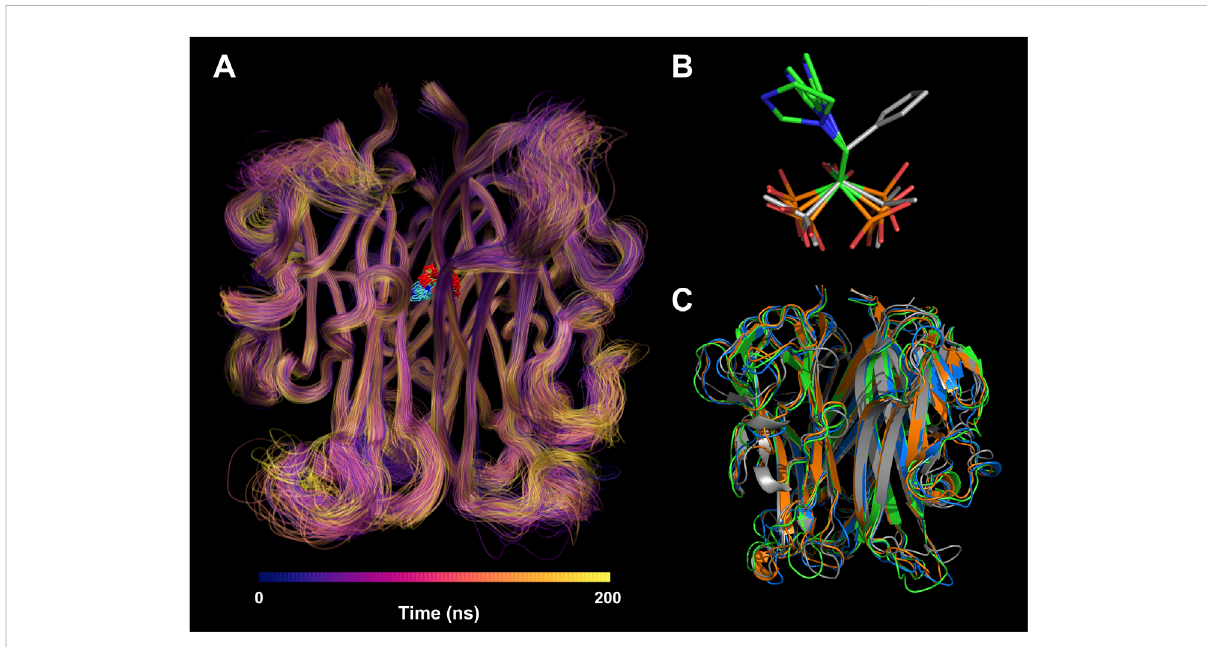
FIGURE 6 Structural visualization of RANKL-ZOL complex in molecular dynamics simulation. (A) Visualization of the MD trajectory of the receptor RANKL in Run 1. The trajectories are colored from deep blue to yellow according to their chronological order; the regions with concentrated trajectories indicate that the structural movement is relatively stable; conversely, regions with loose trajectories imply high structural fl exibility. The trajectory superposition of the ligand ZOL is illustrated at the binding site. (B) The conformational changes of ZOL structures before and after the MD simulation, where the gray stick structure represents the initial conformation before MD simulation, and the colored stick structures represent the resulting conformations after three repeated MD simulations. (C) The conformational changes of RANKL structures before and after the MD simulation,wherethegraycartoonstructurerepresentstheinitialconformationbeforeMDsimulation,andthecoloredcartoonstructuresrepresent the resulting conformations after three repeated MD